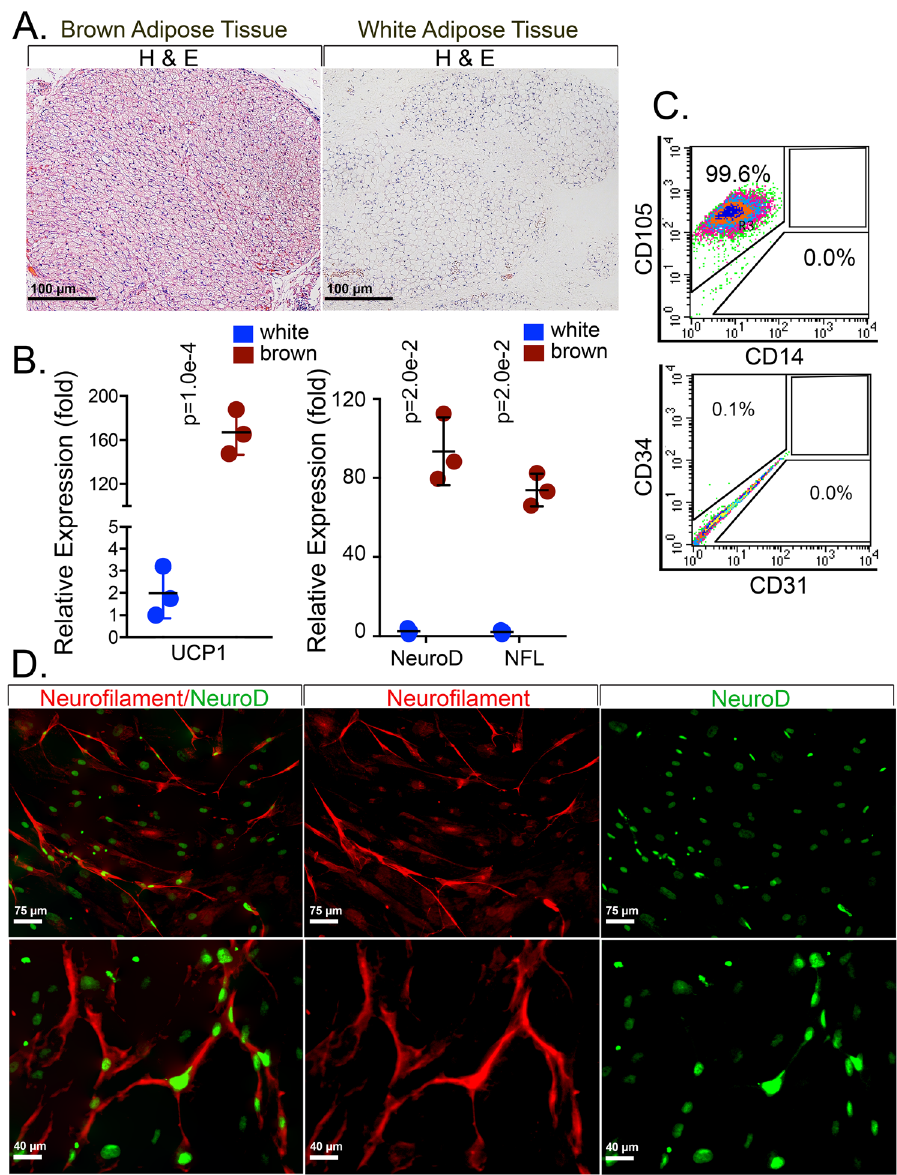
Figure 6. Neurogenic potential in human brDFAT cells. ( A ) H&E staining of human BAT (interscapular) and WAT (subcutaneous) from human autopsy specimens (from subjects less than 3 months of age). ( B ) Expression of Uncoupling protein 1 (UCP1), Neurogenic Differentiation 1 (NeuroD1) and Neurofilament (NFL) in white and brown adipose tissue from human autopsy specimen as determined by qPCR (n = 3 cell preparations). P -values for statistically significant differences are indicated (unpaired t-tests). ( C ) Expression of CD105 and CD34 in human brDFAT cells as determined by FACS on day 7 of culture. ( D ) Expression of NFL (red) and NeuroD (green) in human brDFAT cells after 15 days of culture in neural induction medium, as visualized by immunofluorescence. DAPI (blue) was used to visualize nuclei. Representative images from 3–5